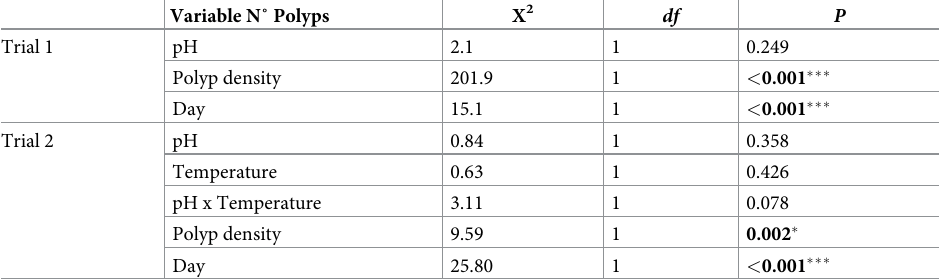
Table 2. Generalized estimating equations model (GEEGLM) and statistical significance of the fixed effects in explaining the variation of the number of